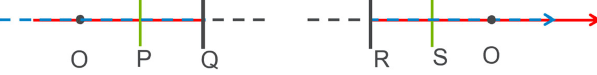
FIG. 2. Unfolded representation of XFELO cavity of Fig. 1. The optical axis is defined along the unperturbed ray path (red) which overlaps with that of the electron beam (blue) in the